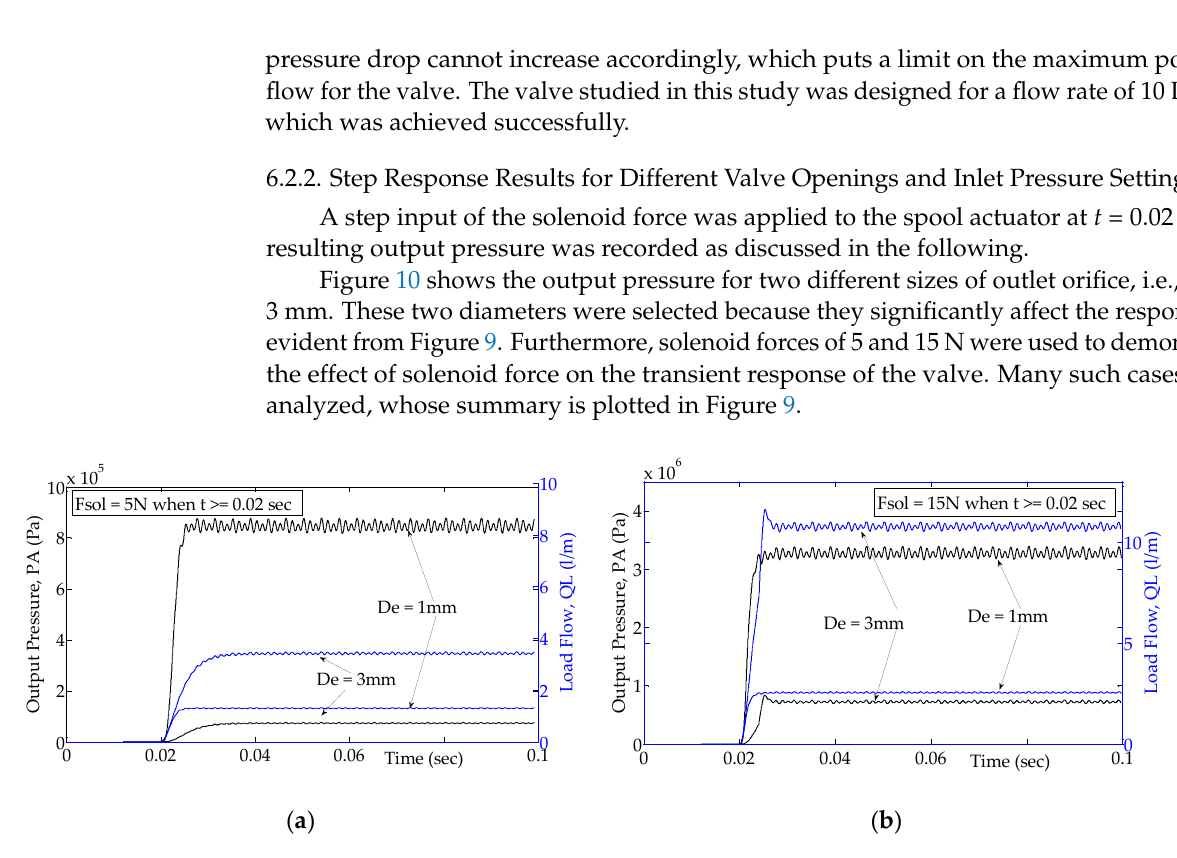
Figure 10. Transient response of output pressure and load flow for two different outlet openings; ( a ) When solenoid’s actuating force is 5 N; ( b ) When solenoid’s actuating force is 15 N.